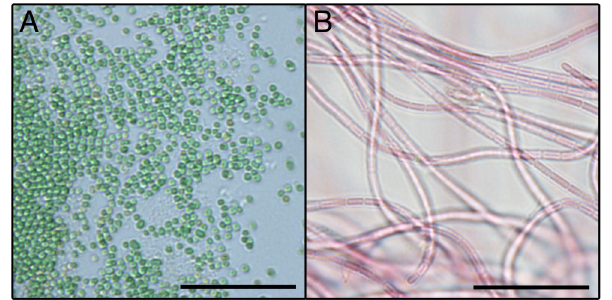
Figure 3. Microphotographs of the two cyanobacterial strains known to produce 1. A – Cyanobium sp. LEGE 06133; B – Phormidium